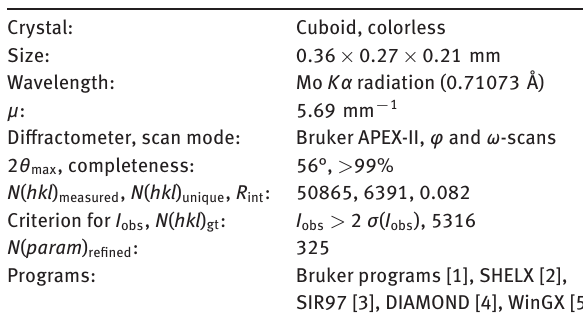
Table 1: Data collection and handling.